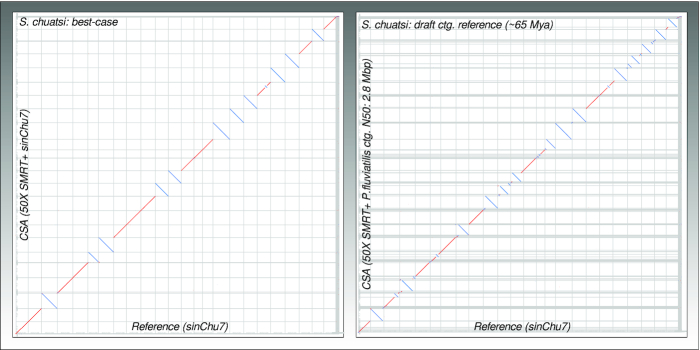
Dot plots of CSA results against reference genome for assembly of Siniperca chuatsi supported by contigs of a diverged draft genome assembly in comparison to the best-case CSA assembly. For explanation of the dot plot properties, see Figure 2.